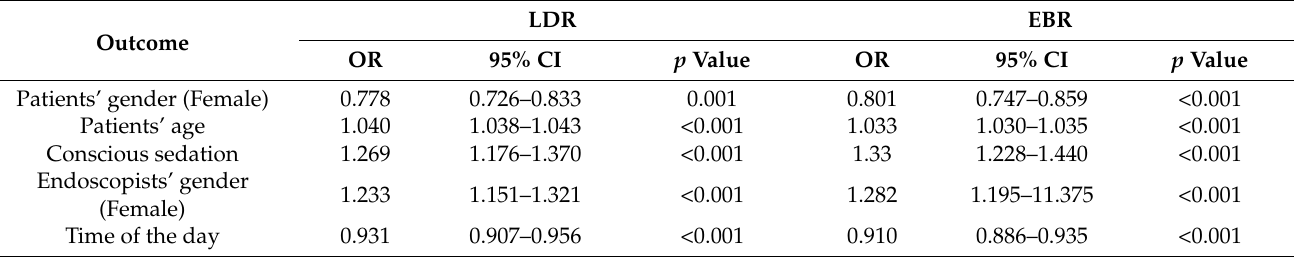
Table 3. Univariable logistic regression analysis.